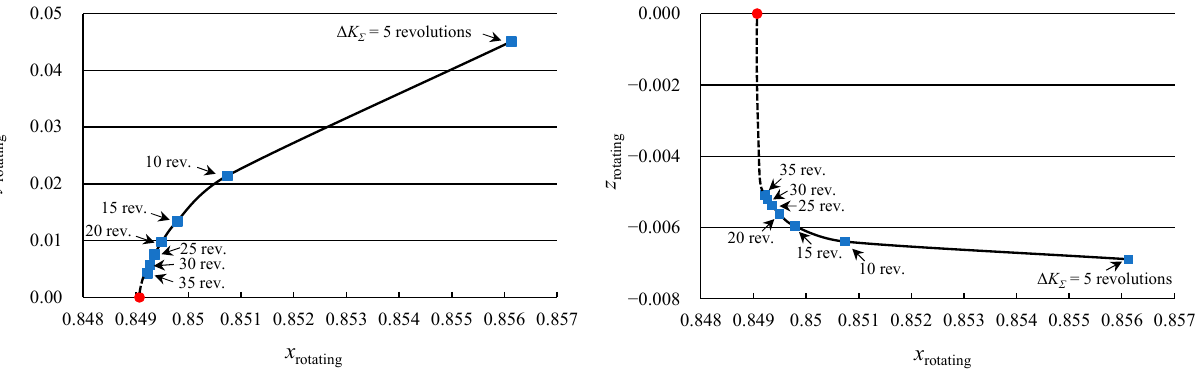
Figure 6. The positions of the optimal junction points in the rotating coordinate system onto the XY (on the left) and XZ (on the right) planes.